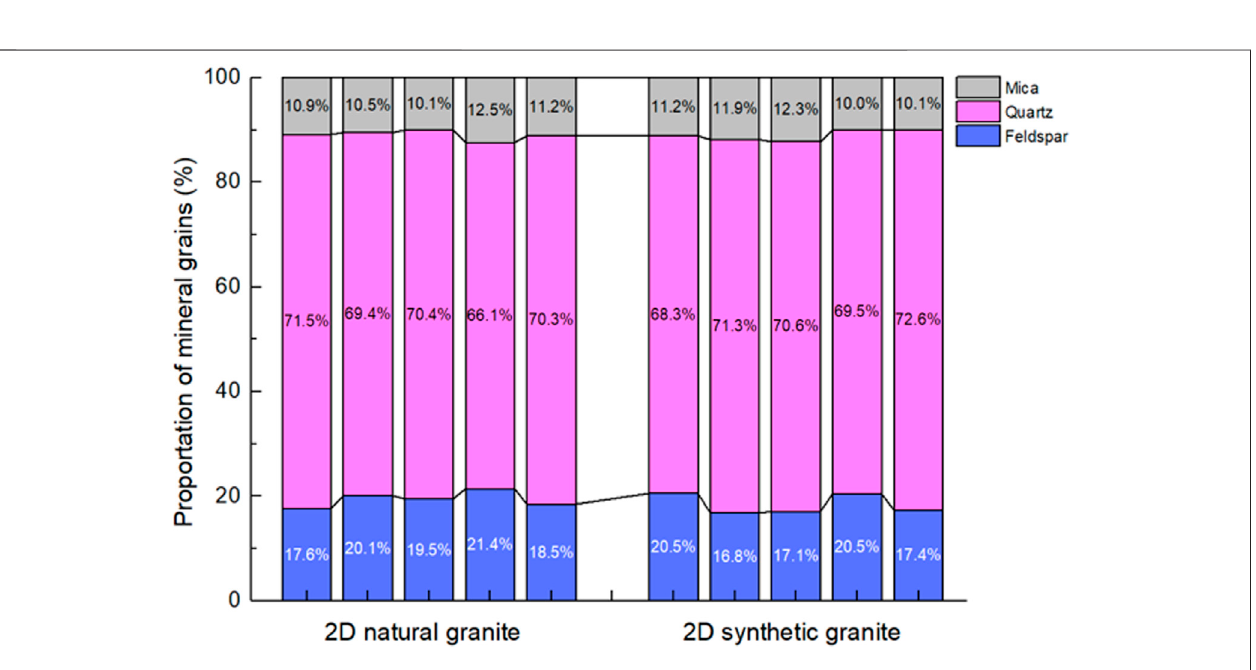
FIGURE 5 | The proportion of mineral grain in natural and synthetic